Question: Sum up the contents of this chart in one sentence.
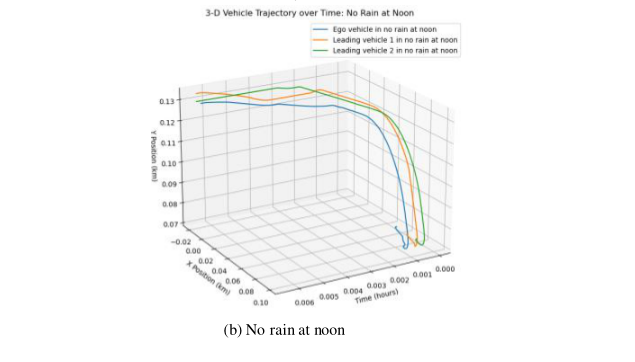
Answer: 3-D vehicle trajectory over time at a curved unsignalized